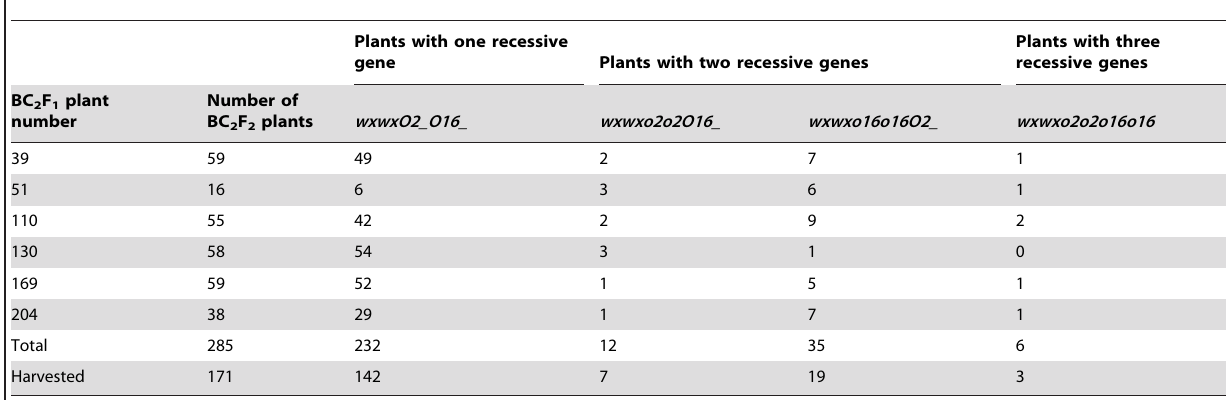
Table 3. Foreground selection for BC 2 F 2 population using SSR markers.